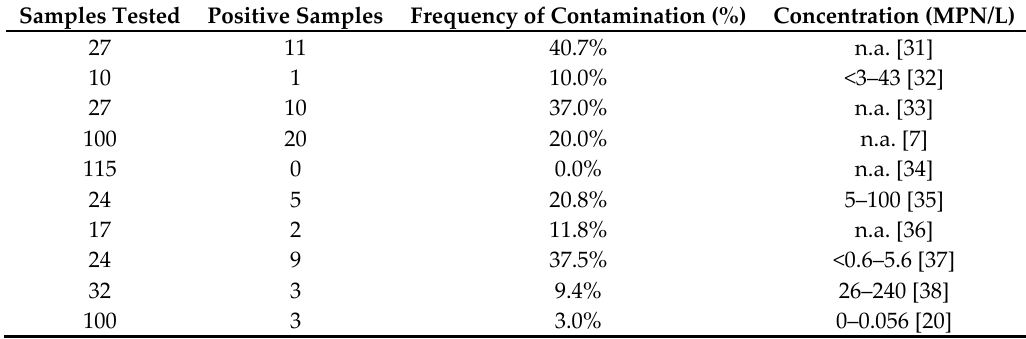
Table 1. Presence of Campylobacter in stored roof-harvested rainwater (RHRW) from different sources.